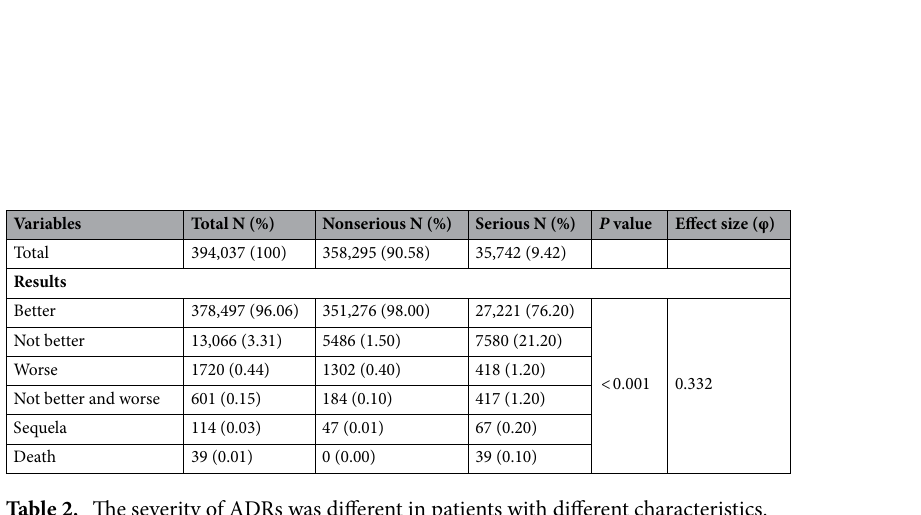
Table 2. The severity of ADRs was different in patients with different